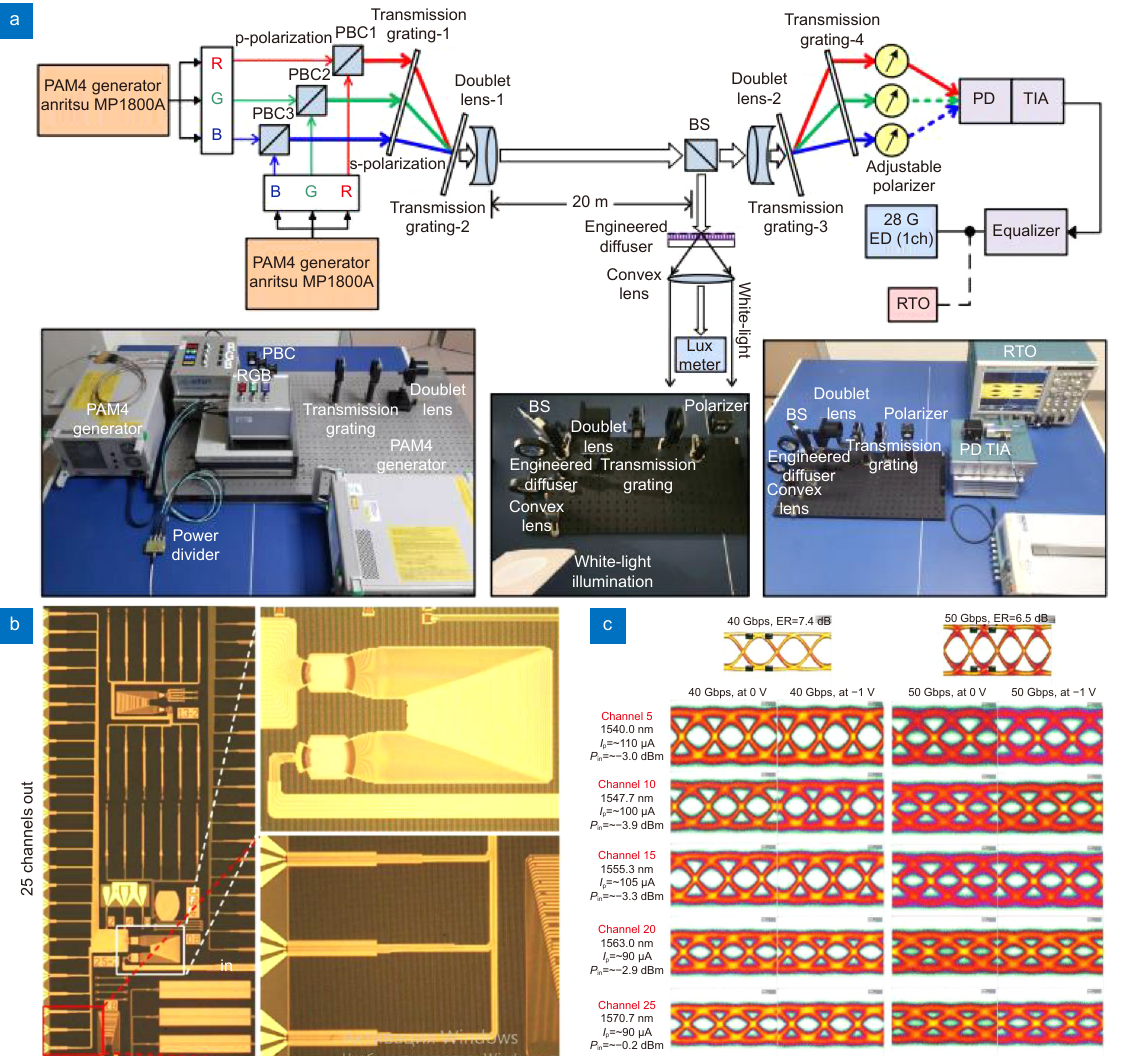
Fig. 4 | ( a ) Graphical illustration of the white-lighting and WDM-VLC network utilizing broadcast gratings and a tailored diffuser over a 20 m FSO link with a 3 m lighting distance. ( b ) Optical micrographs of the WDM receiver chip. ( c ) 40 Gbps and 50 Gpbs eye diagrams of channels 5, 10, 15, 20 and 25 at 0 and –1 V. The modulator eye graphs are also displayed for evaluation. Figure reproduced from: (a) ref. 35 , Optical Society of Amer- ica; (b) ref. 36 , Optica Publishing Group, under the Optica Open Access Publishing